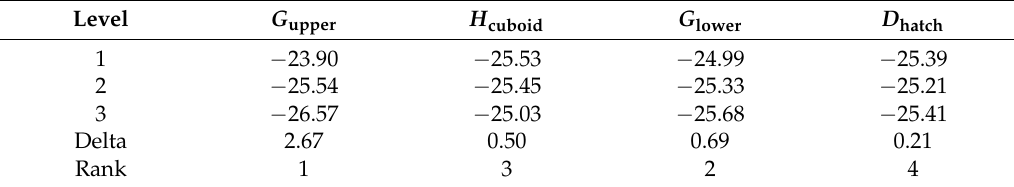
Table 7. Average S / N ratio for Roughness ( R a ).